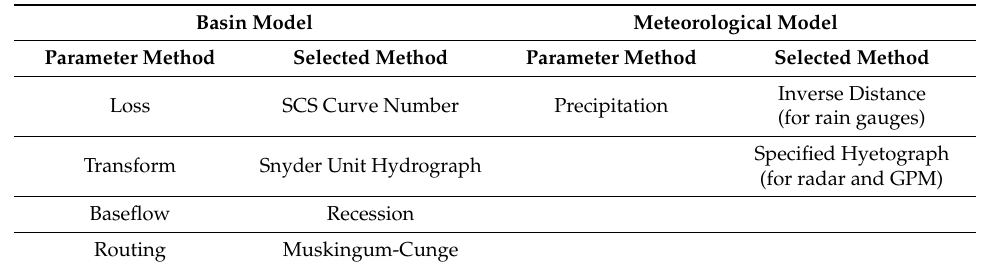
Table 3. Selected methods for the Hydrologic Engineering Center-Hydrologic Modelling System